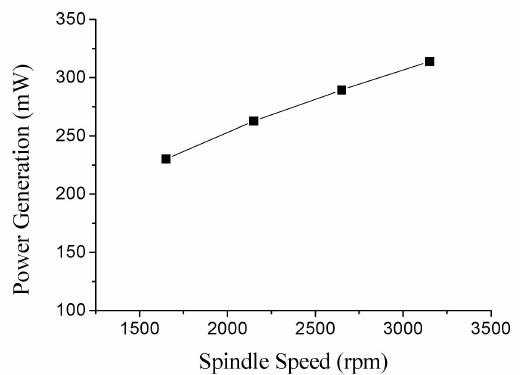
Figure 5. Power generation from the energy harvester at different spindle’s speeds.